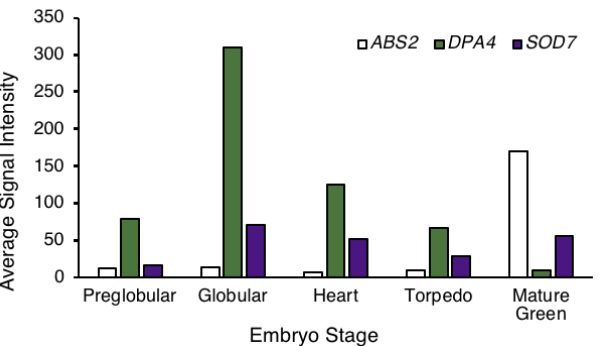
Figure 6. ABS2 , DPA4 and SOD7 mRNA accumulation levels at different embryo developmental stages. Data were retrieved from [50] . stages. Data were retrieved from